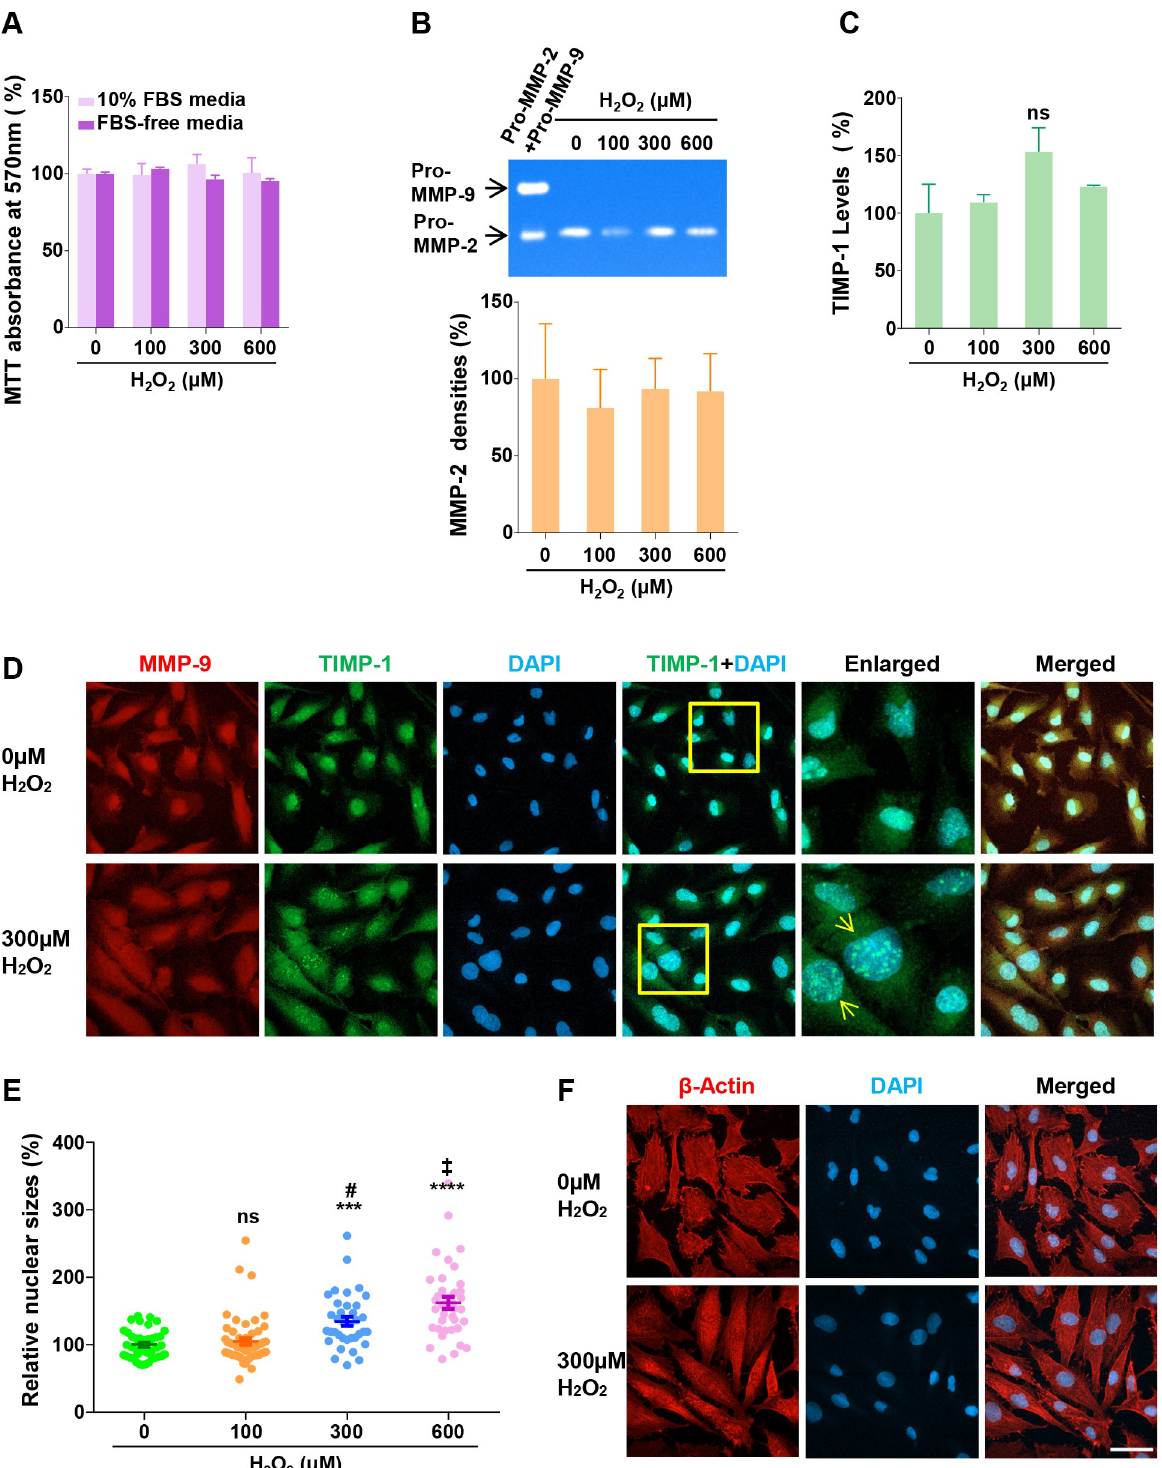
Fig 4. Effect of oxidative stress on intracellular MMP-9 and TIMP-1. (A) MIO-M1 cells were cultured in the presence of H 2 O 2 at indicated concentrations in the regular (10% FBS) or FBS-free media, for 24 h, and then subjected to MTT assay to measure viable cell densities. Relative cell densities are presented as % mean ± SE (n = 3), with control (0 μ M) set as 100%. (B) The cells were treated in the same way as in (A), and then CMs were collected, to perform gelatin zymography and ELISA assay. (Top) the CMs of the same volume from each treatment was subjected to